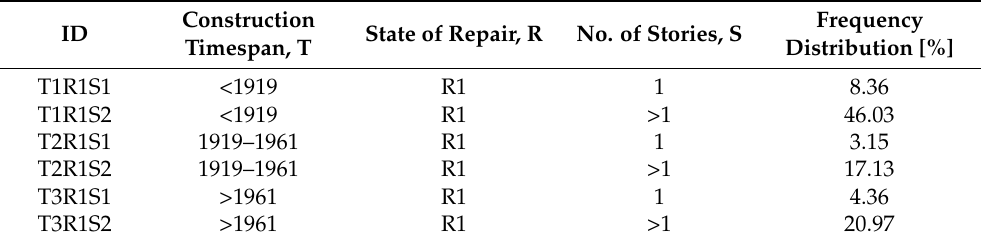
Table 5. Census building typological classification and relative frequency distribution accounting for construction timespan, state of repair R1, and number of